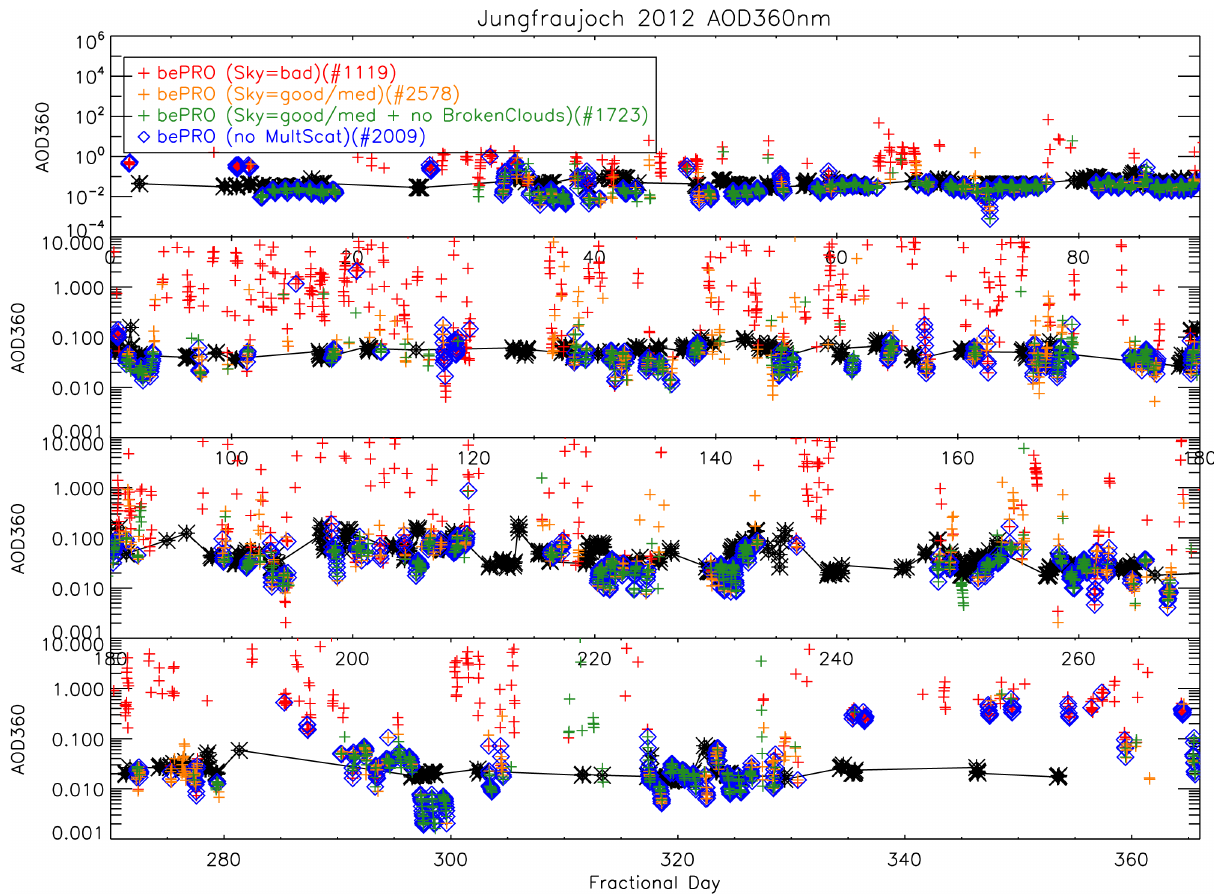
Table 1. Overview of the number of retrieval points removed by the cloud-screening procedure. We give both the statistics for CI cloud screening based only on the zenith elevation angle (top) and cloud screening based on both the 30 and 90 ◦ elevation angles (bottom). The first column shows the respective site and wavelength, the second column gives the total number of points before cloud screening, the third column provides the percentage of data remaining after removing data with a “bad” CI flag, the fourth after removing data with a “bad” CI flag and a broken-cloud flag. The last column gives the percentage of data remaining after removal of data with a multiple-scattering flag. Place + Total number CI-flag = good/med CI-flag = good/med + No multiple scattering wavelength of data points No broken clouds 90 ◦ Xianghe 360nm 29740 46% 36% 63% Xianghe 477nm 30780 46% 37% 63% Brussels 360nm 32% 35% 51% 55%